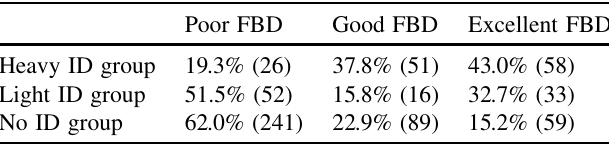
TABLE VII. Crosstab for the two FBD questions in three groups. The number of FBDs is reported in parenthesis.